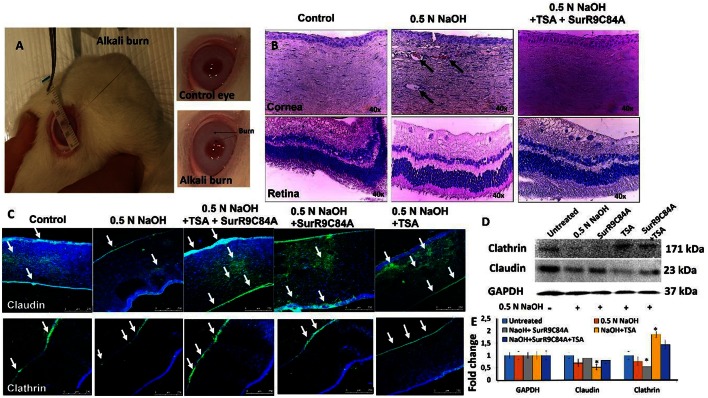
SurR9C84A initiates wound healing in conjunctiva and cornea. (A) Induction of alkali burn using a filter strip in rabbit cornea. Ring shaped burn signs observed in the alkali burn rabbit cornea. (B) NaOH induced alkali burn disrupts corneal structure: The H & E images obtained using the rabbit corneal and retinal sections in the control group showed no signs of disturbance and maintained epithelial integrity. While the NaOH insult induced vacuole formation indicating corneal degeneration and infiltration of blood cells in stromal layer of cornea. The treatments with SurR9-C84A+TSA, SurR9-C84A and TSA didn't show any signs of vacuolated disturbance and infiltration and almost resembled the control group. (C) NaOH led to nearly complete disruption of clathrin and claudin expression in conjunctiva and cornea while SurR9-C84A+TSA led to revival of both clathrin and claudin expressions and therefore induced healing of conjunctival and corneal layer. (D) Western blotting results confirm that SurR9-C84A+TSA helps in regeneration of conjunctival and corneal layer. (E) Graph representing the densitometric analysis of the western blots showing variations in the fold change of proteins. Data represents mean ± SEM. Experiments were repeated 3 times in triplicates. Representative images have been presented. *P < 0.05.